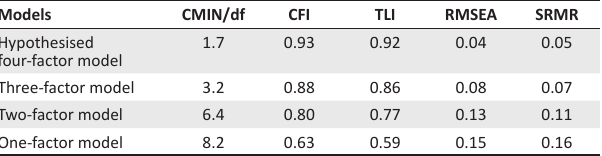
TABLE 3: Structural equation modelling results.